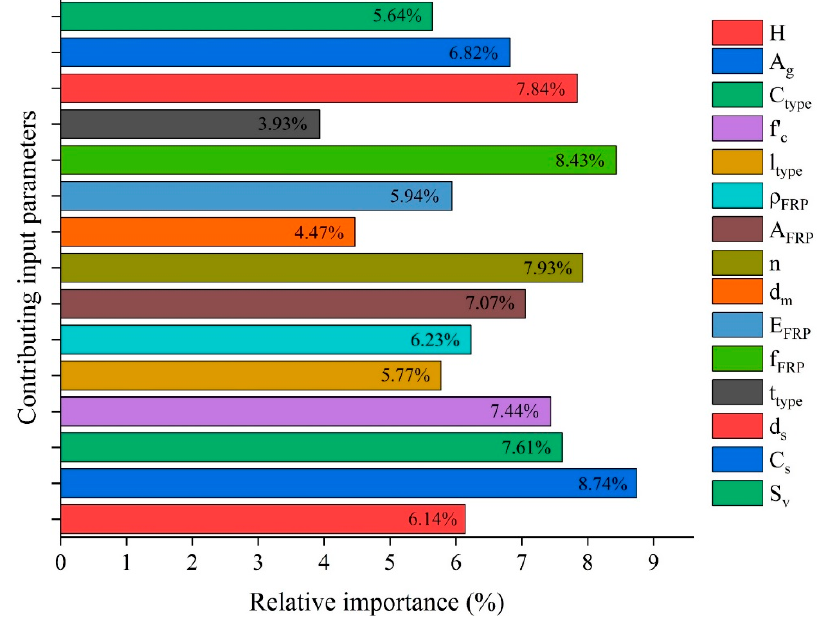
Figure 9. Sensitivity analysis